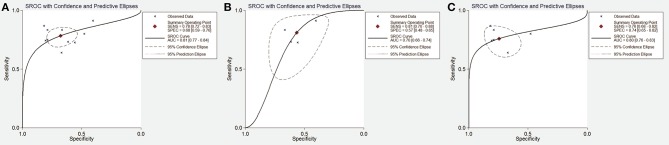
Summary receiver operating characteristic curve for test accuracy of adiponectin upon metabolic syndrome diagnosis. (A) SROC curve for accuracy of ADPQ upon MetS diagnosis in all cohorts; (B) SROC curve for accuracy of ADPQ upon MetS diagnosis in adult cohorts; (C) SROC curve for accuracy of ADPQ upon MetS diagnosis in adolescent cohorts. ADPQ, adiponectin; SROC, summary receiver operating characteristic; MetS, metabolic syndrome.